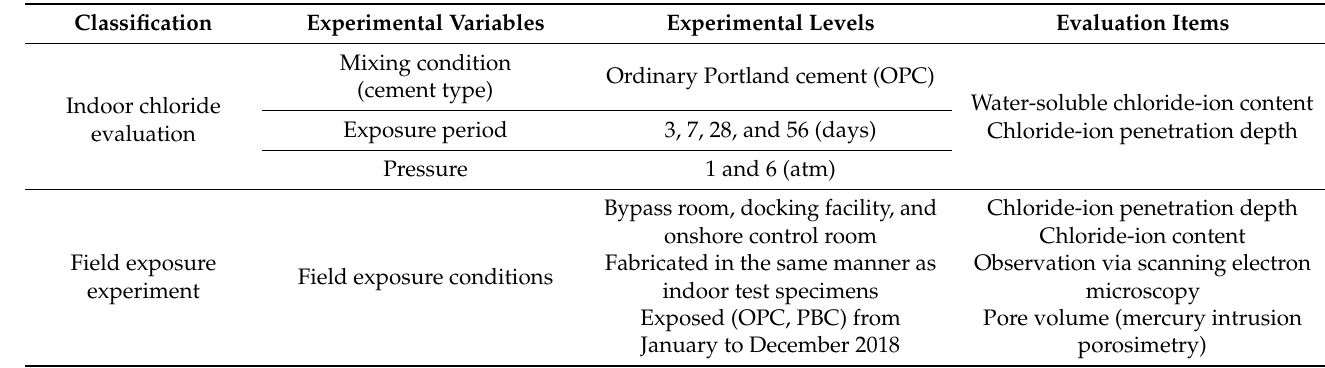
Table 3. Design of experiments 2.